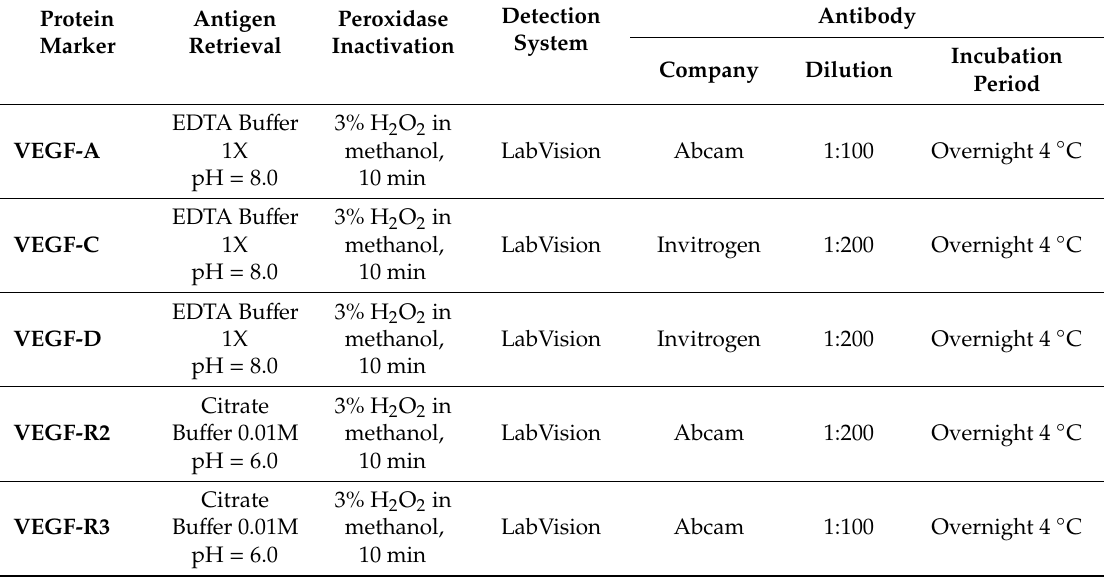
Table 9. Detailed aspects of the immunohistochemical procedure used to visualize the di ff erent